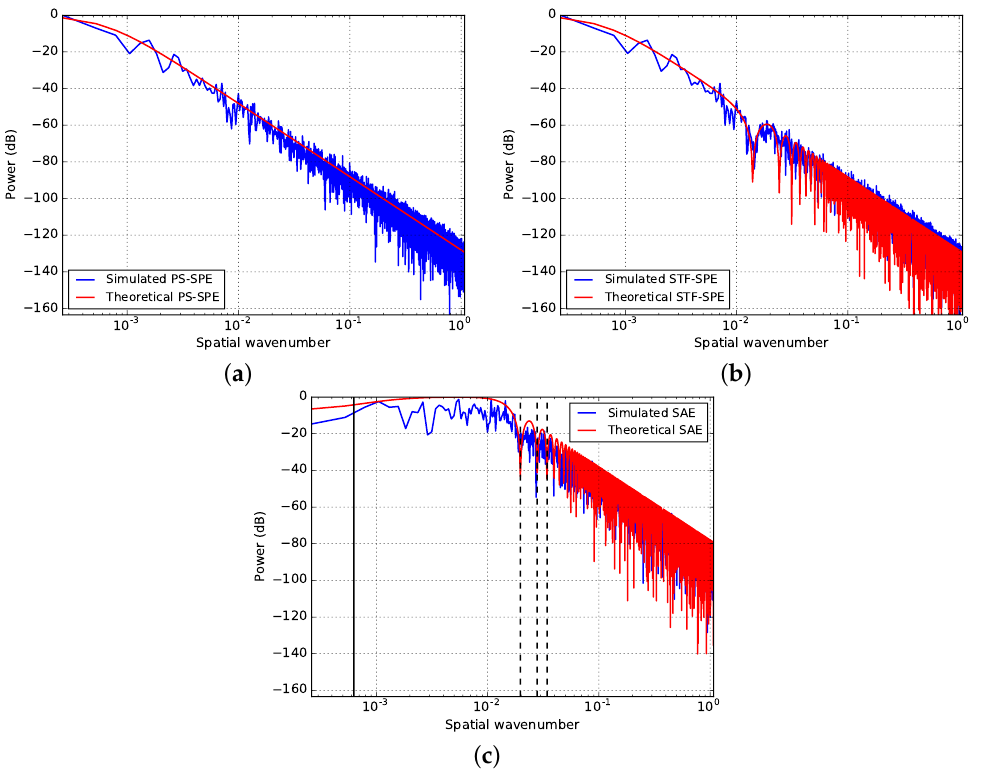
Figure 3. SDF. ( a ) Simulated and theoretical PS − SPEs; ( b ) simulated and theoretical STF − SPEs; ( c ) simulated and theoretical SAEs. The black solid line denotes the wavenumber as to the outer scale, and the black dashed lines refer to the first three Fresnel cutting